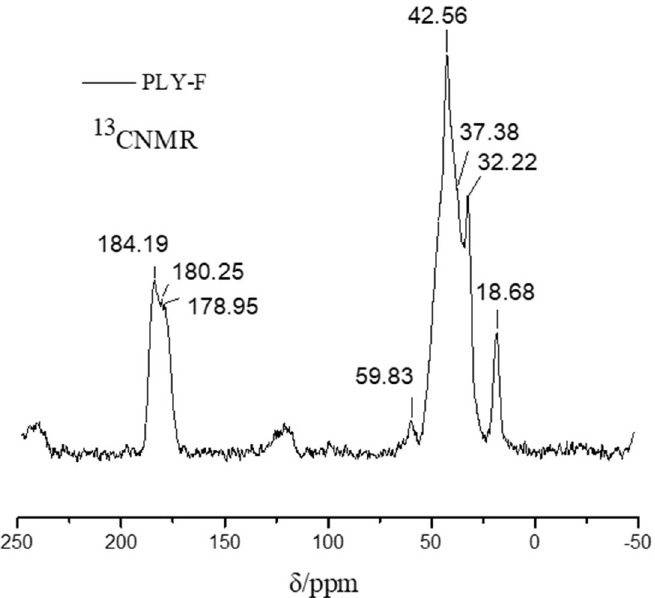
Figure 5. The spectrum of 13 C NMR of temperature and salt resistant polymer PLY-F.